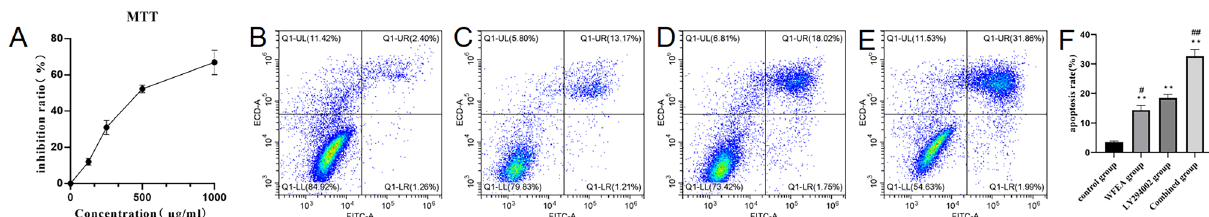
Figure 8. Effects of WFEA on lung adenocarcinoma cell viability and apoptosis. ( A ) cell viability analysis; ( B ) cell apoptosis analysis in control group; ( C ) cell apoptosis analysis in WFEA group; ( D ) cell apoptosis analysis in LY294002 group; ( E ) cell apoptosis analysis in combined group; ( F ) histogram of apoptosis rate. * p < 0.05 and ** p < 0.01 compared with blank group, # p < 0.05 and ## p < 0.01 compared with LY294002